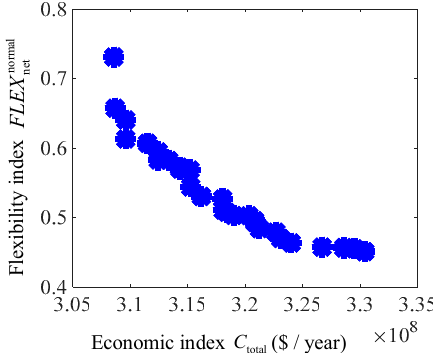
Figure 3. Flexibility–Economy pareto frontier. Table 1. Comparison of planning scheme results in typical scenarios.